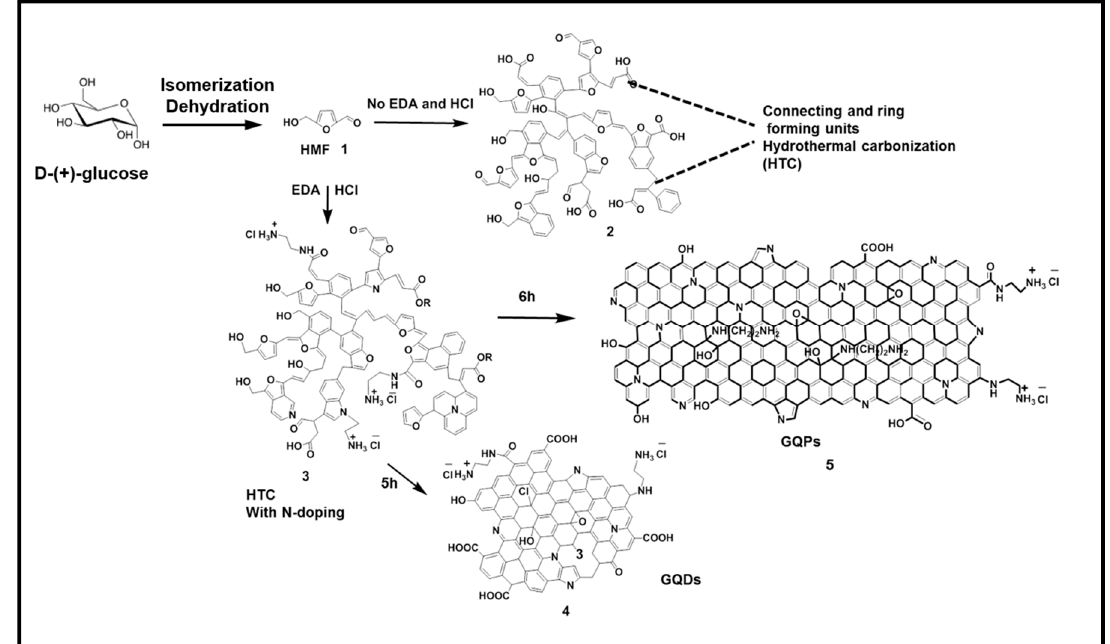
Scheme 1. The growth mechanism of GQPs from glucose.